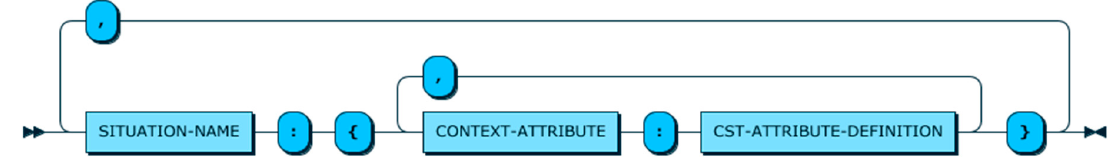
Figure 19. CST-SITUATION statement production rule.